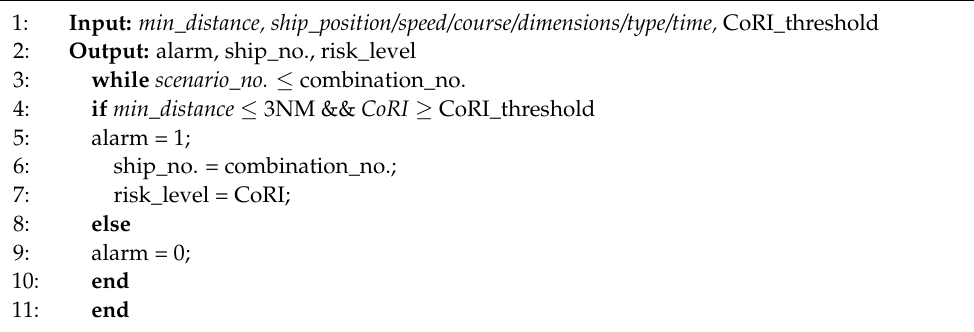
Algorithm 1. Collision risk assessment algorithm in multi-ship